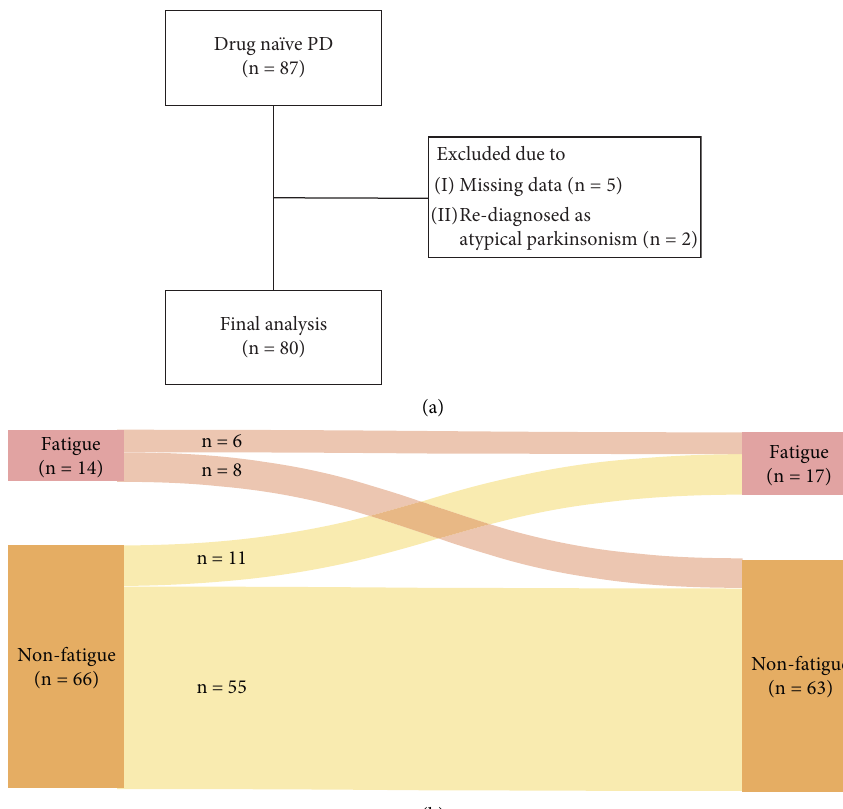
Figure 1: Study overview. A total of 87 patients were screened, and 7 were excluded from the analysis due to missing data and diagnosed as atypical parkinsonism during the follow-up period (a). Six of the 14 (42.9%) patients of the fatigue group had persistent fatigue at the follow- up investigation; in contrast, with medication, eight of them (57.1%) converted to the nonfatigue group. Among the nonfatigue group at the follow-up, eleven patients (16.7%) converted to the fatigue group and 55 (83.3%) remained in the nonfatigue group (b). PD: Parkinson’s